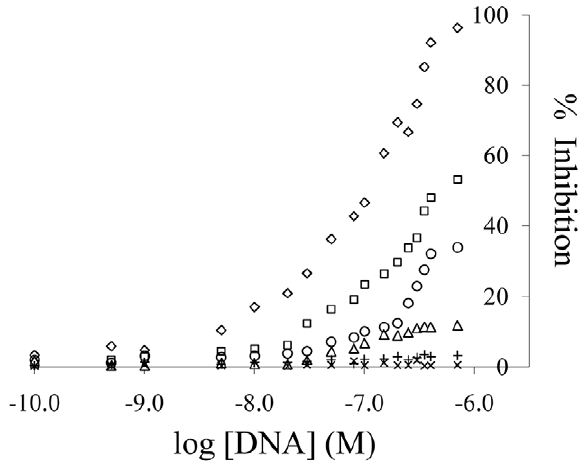
Figure 6. Effect of selected motif I aptamers on clotting activity of a -thrombin. Thrombin activity was measured in the presence of varying concentrations of selected sequences with the corresponding counts shown in the legend (the sequences are listed in Tables 3 and S4). Motif II sequences had no effect on the clotting times.